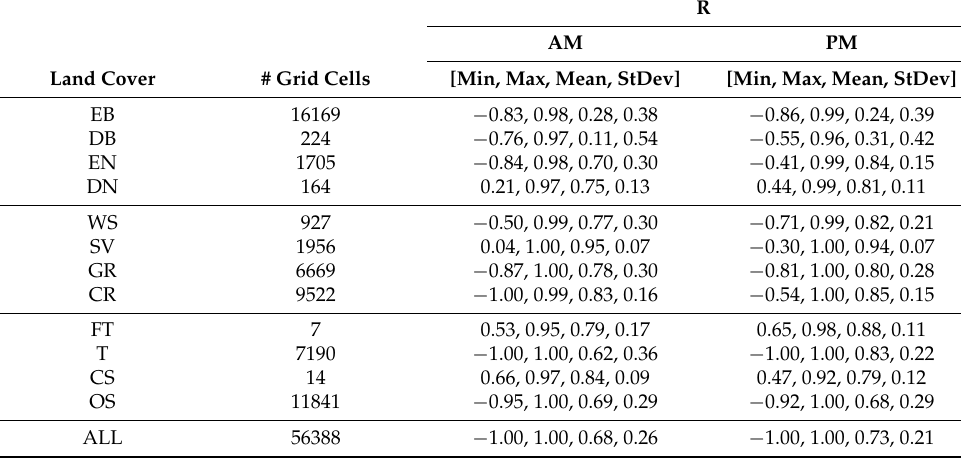
Table 2. Dominant land cover, # of participating grid cells and A.M. and P.M. minimum, maximum, mean and standard deviation Pearson’s correlation coefficients (R) between overlapping, snow screened and time-averaged daily C-band ASCAT and K u -band QSCAT backscatter time series data (11/2008–11/2009). Relationships are significant at a minimum 0.01 probability